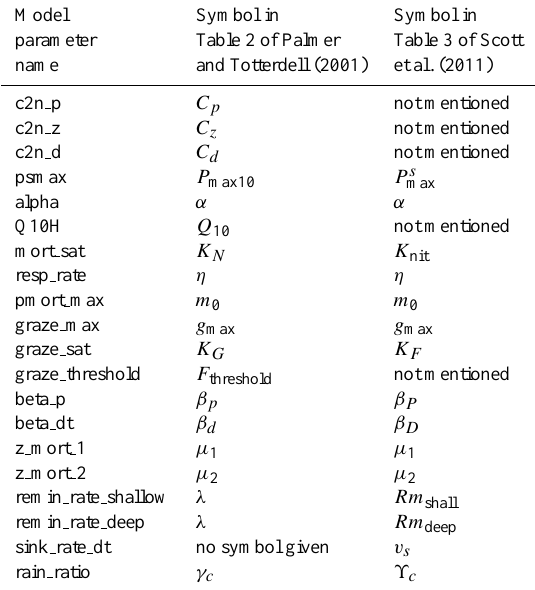
Table 4. Comparison of nomenclature used in Scott et al. (2011) and Palmer and Totterdell (2001) to describe analogous ocean bio- geochemical